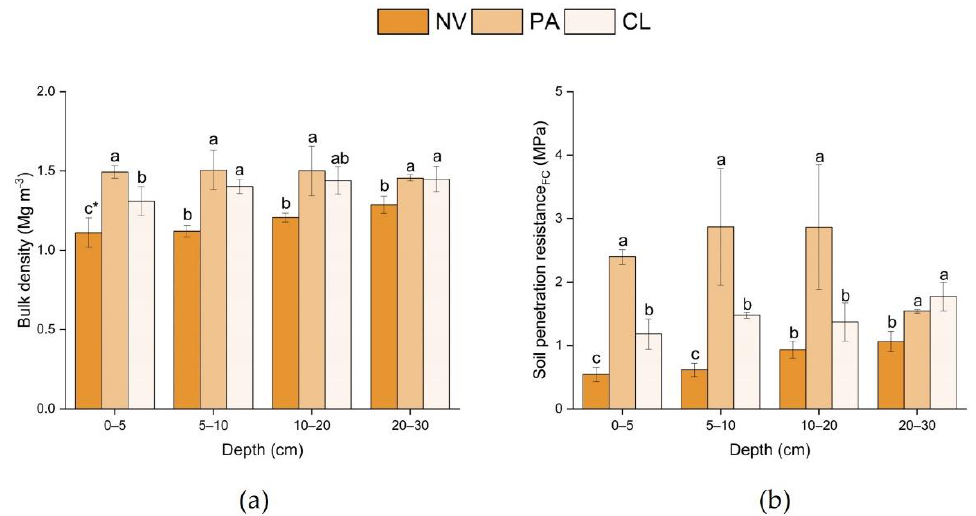
Figure 2. ( a ) Bulk density and ( b ) soil penetration resistance at field capacity at 0–5, 5–10, 10–20, and 20–30 cm soil layers under cropland (CL), pasture (PA), and native vegetation (NV) areas. * Means followed by the same letter within the same soil layer are equal to Tukey’s test ( p < 0.05). Vertical bars represent the standard deviation of the